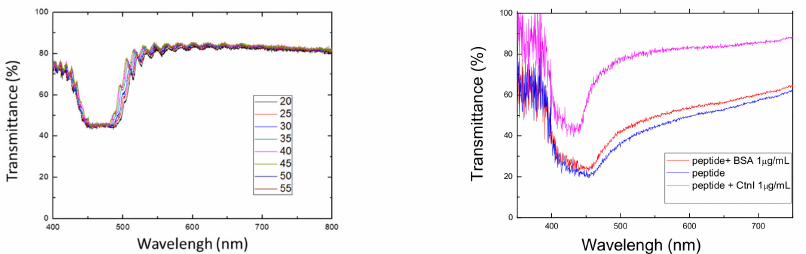
Figure 8. The spectra of the CLC test kit under different temperatures (left) and peptides with different biomolecules